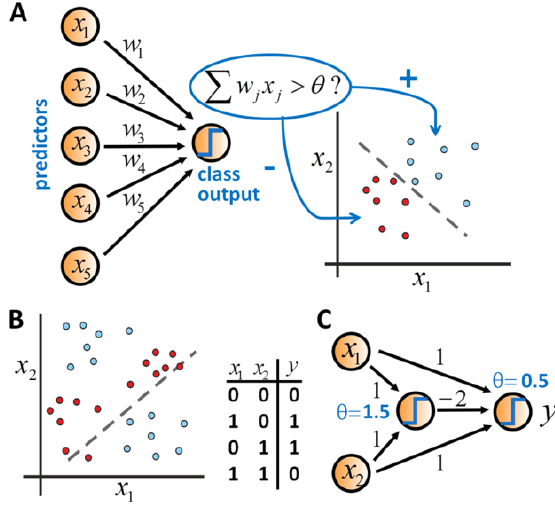
Fig. 3 Neural network model for sentence lattice role